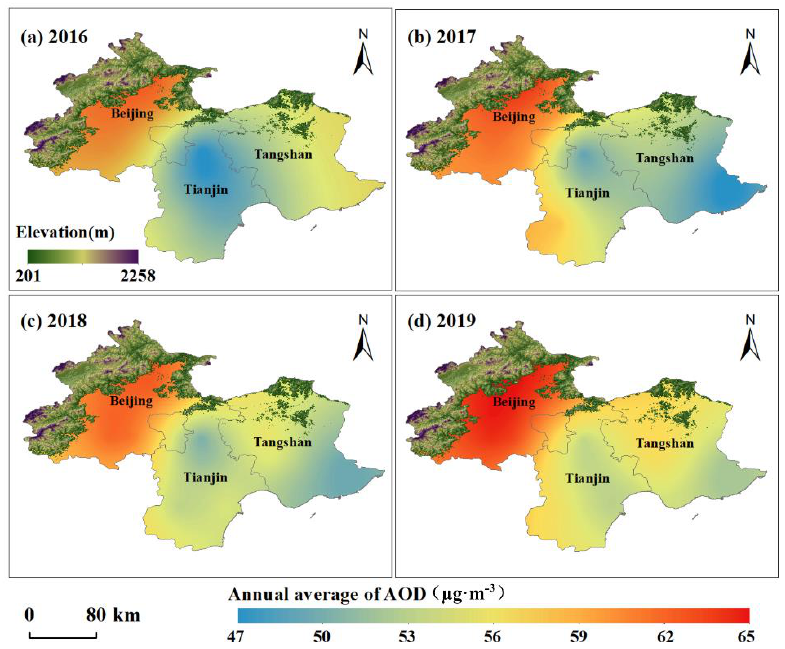
Figure 2. Spatial distributions of surface ozone average concentration in the BJ-TJ-TS region from 2016 to 2019. Table 1. Dynamic changes in surface ozone average concentrations in study region from 2016 to